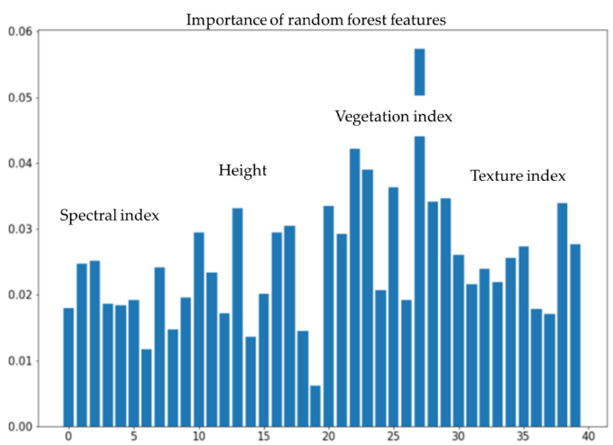
Figure 13. The importance of features in the estimation of different vegetation species compositions. The x-axis is the number of features, and the y-axis is the importance of the